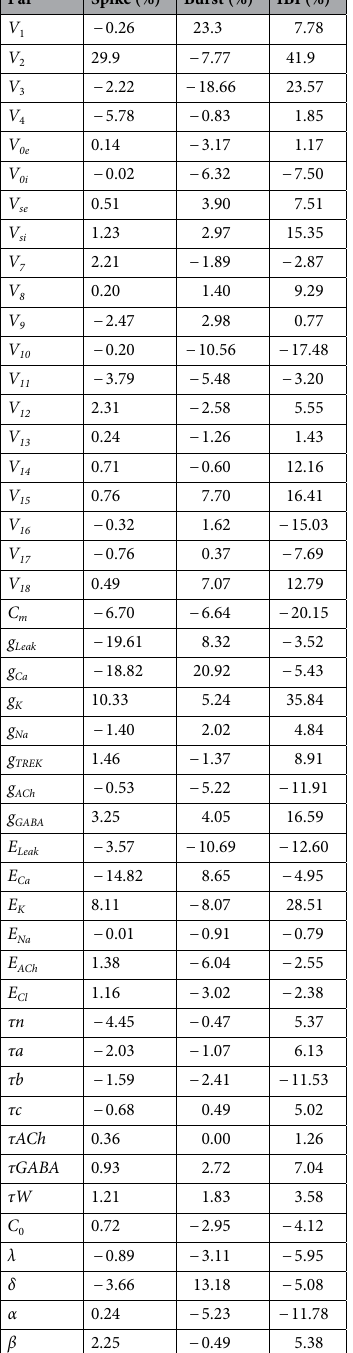
Table 5. Parameter gradients versus each of the model properties. Gradients are indicated as percent